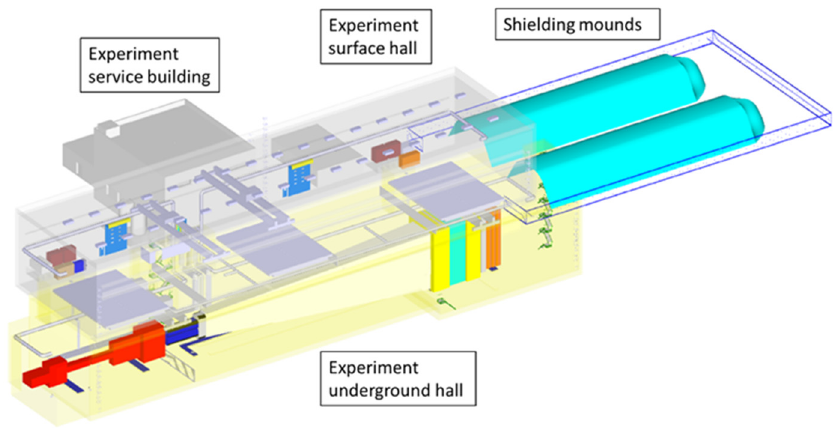
Figure 2. Layout of the SHiP experimental area.